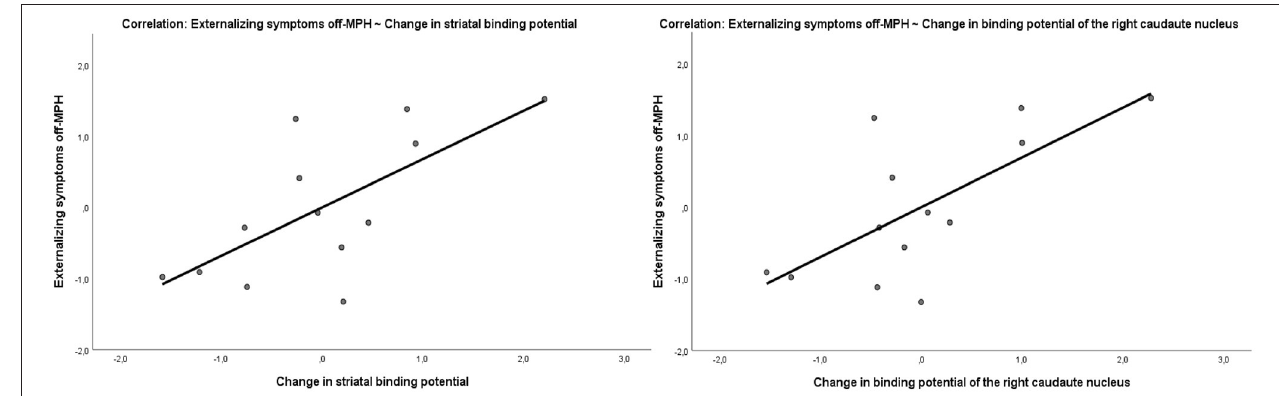
FIGURE 5 | Correlation of the externalizing symptom score off-MPH with the change of binding potential in the striatum (Pearson r = 0.68, p = 0.01) and in the right caudate nucleus (Pearson r = 0.7, p = 0.008).